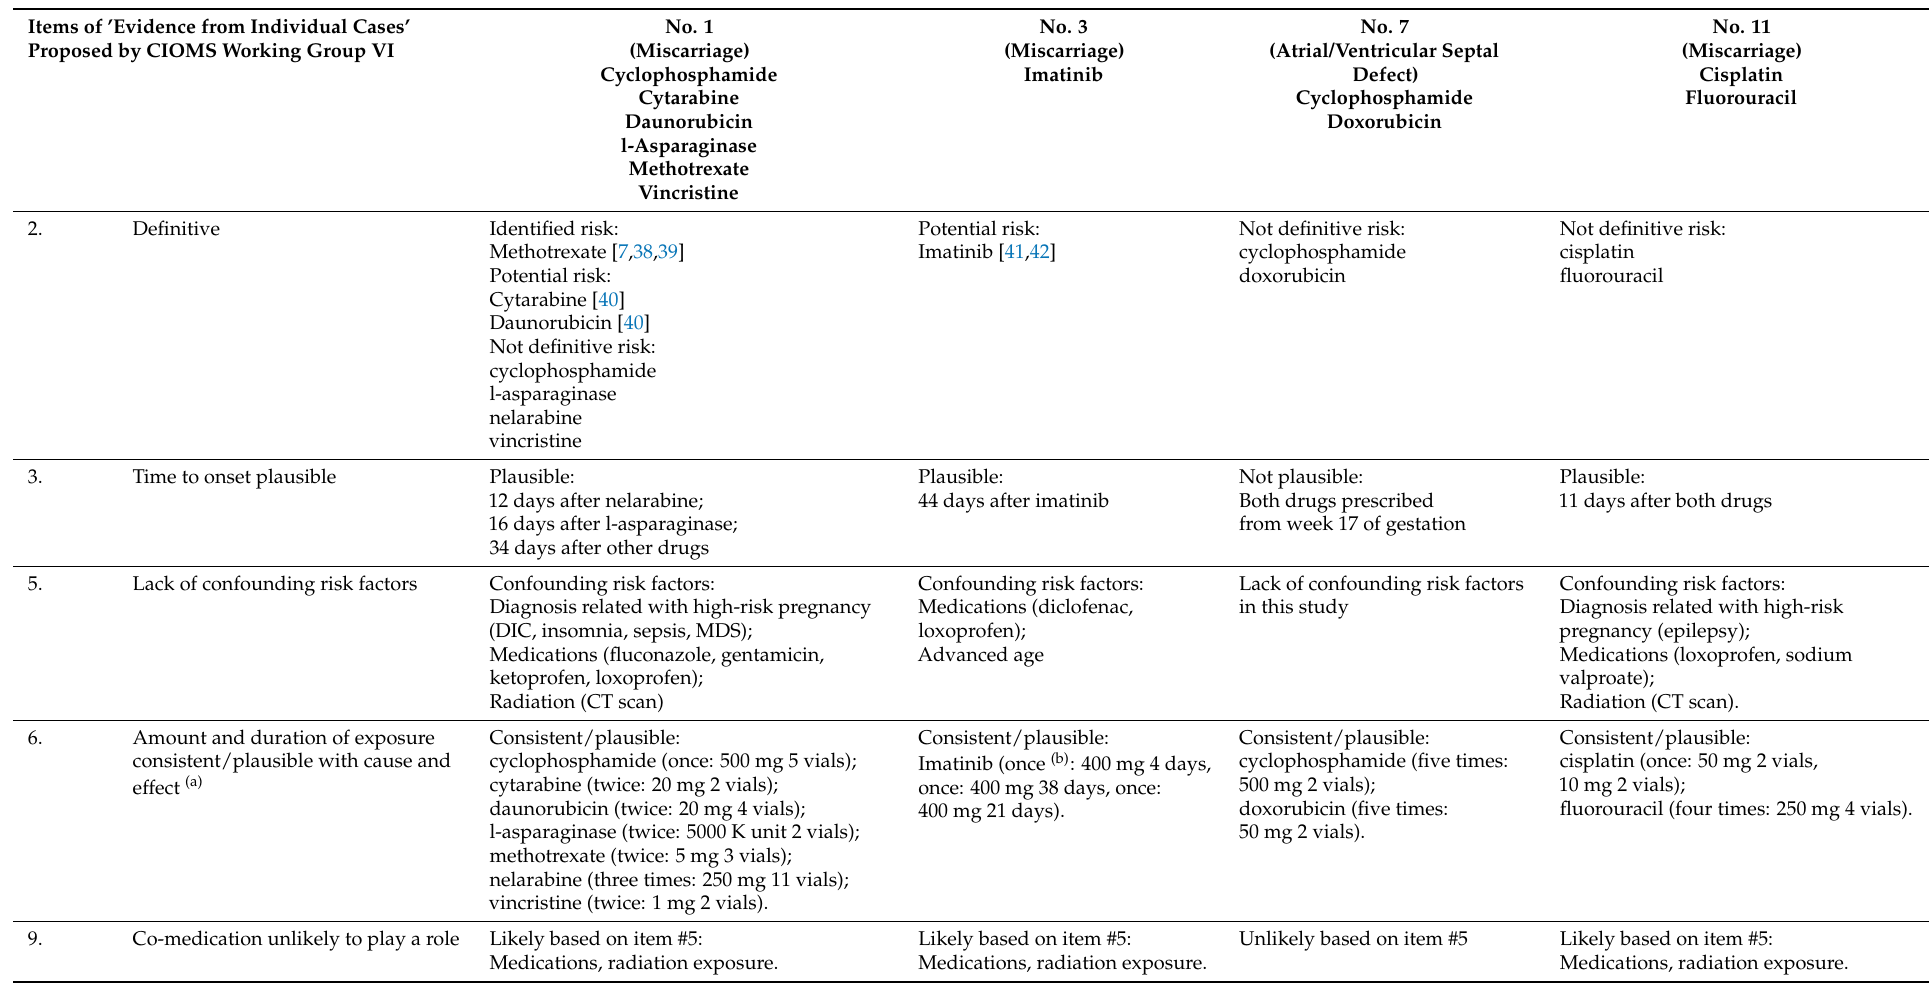
Table 3. Assessment of the causal relationship between anticancer drugs and adverse birth outcomes based on the criteria proposed by CIOMS working group VI. Items of ’Evidence from Individual Cases’ Proposed by CIOMS Working Group